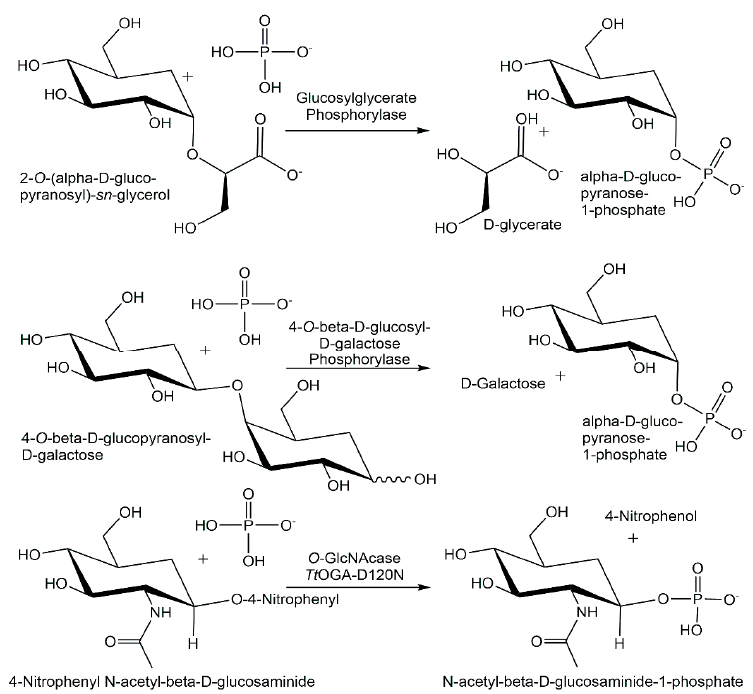
Figure 9. Novel phosphorylases for phosphorylation reactions.